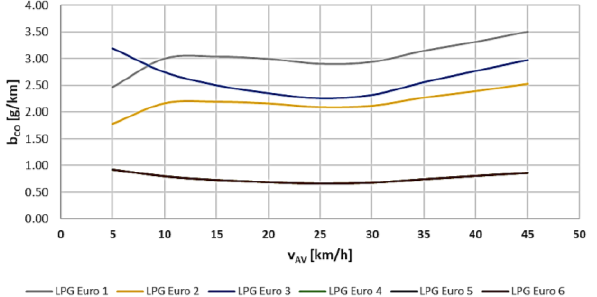
Fig. 31. CO emission from LPG PCs for Euro standards depending on average speed